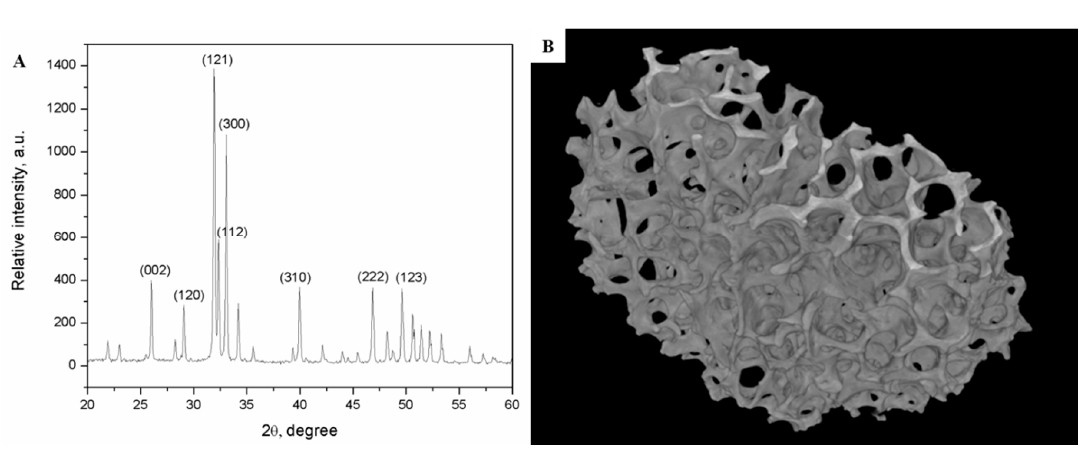
Figure A1. ( A ) XRD pattern of HA; ( B ) Micro-CT scan of Figure S1. (A ). XRD pattern of HA; ( B ). Micro-CT scan of nanoHAP-PLGA. Table S. Values of ALBO-OS porosity.